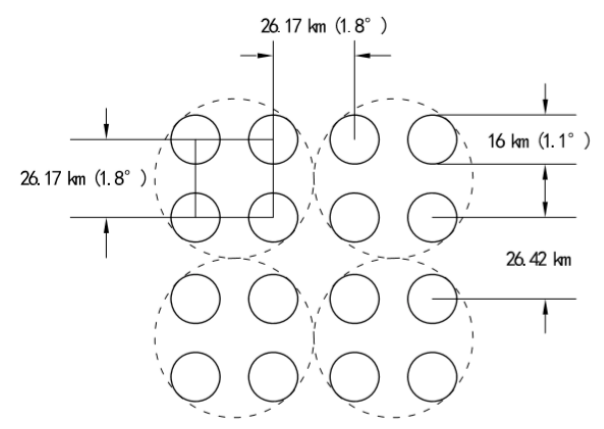
Figure 1. Distribution and corresponding ground field map of the HIRAS detector.